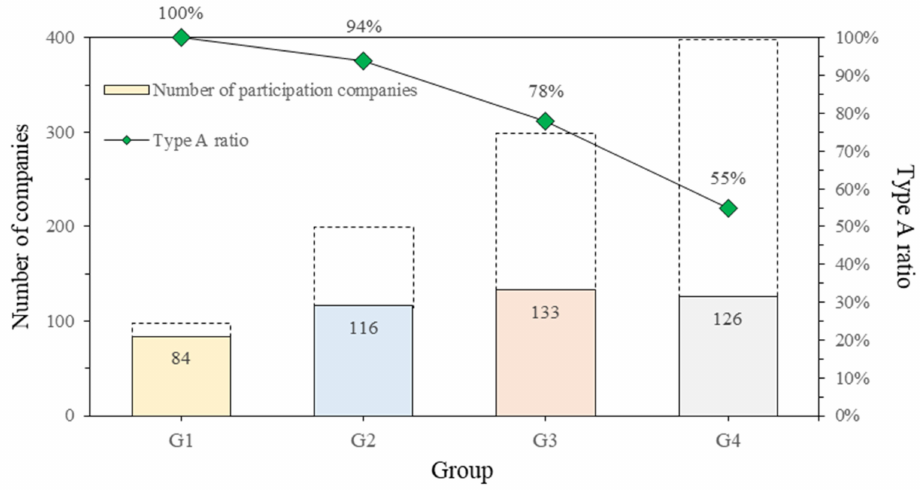
Figure 6. Participation and Type A holding ratio by classified